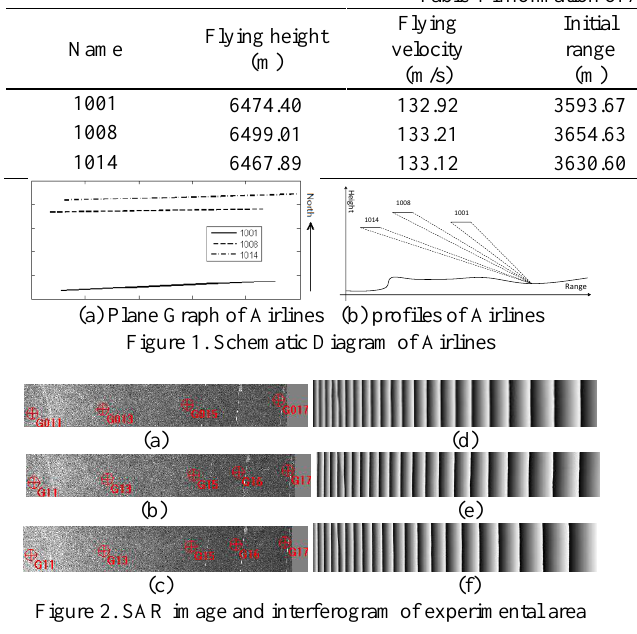
Figure 2. SAR image and interferogram of experimental area